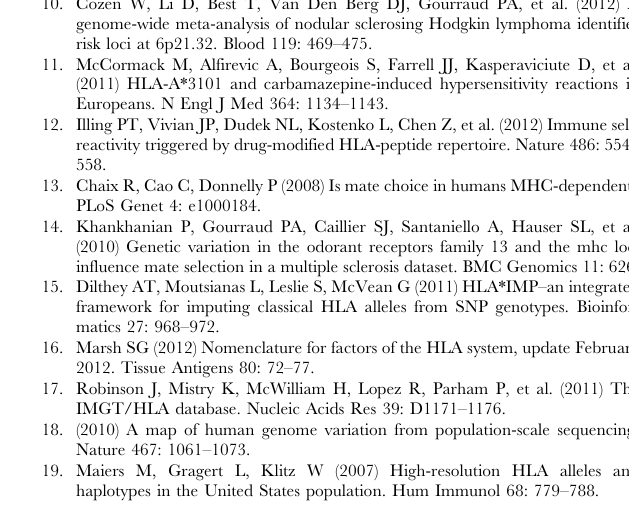
Table S1 MHC region definitions. Table S2 HLA Allele frequencies in the samples of the 1000 Genomes. Table S3 HLA alleles grouped by similarities in the antigen recognition site. Table S4 The most frequent ancestry specific HLA haplotypes. Table S5 Variants associated with frequent haplotypes in